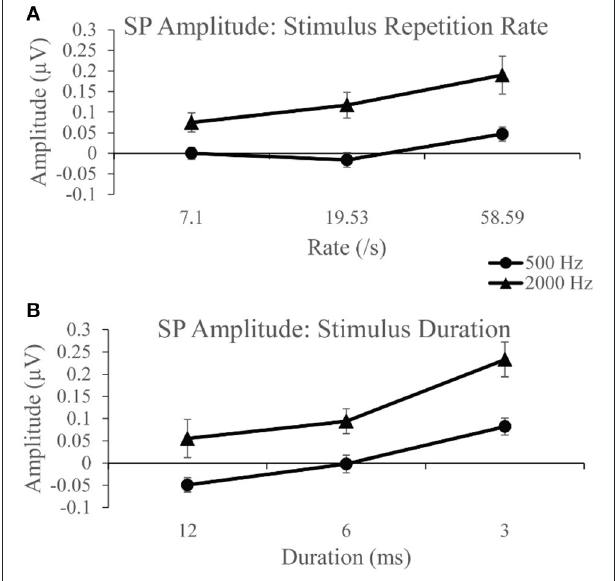
FIGURE 4 | (A) SP amplitudes to 500 and 2,000 Hz varied with stimulus repetition rate (7.1, 19.53, and 58.59/s). SP amplitude to both 500 and 200 Hz were larger for 58.59/s compared to rates 7.1 and 19.53/s. (B) SP amplitudes to 500 and 2,000 Hz varied significantly with stimulus duration (12, 6, and 3 ms). SP amplitudes to 500 Hz were significantly larger for 3 ms stimulus duration than for 12 ms durations and 6 ms durations. Likewise, SP amplitudes to 2,000 Hz were significantly larger for the 3 ms stimulus duration than for 12 and 6 ms